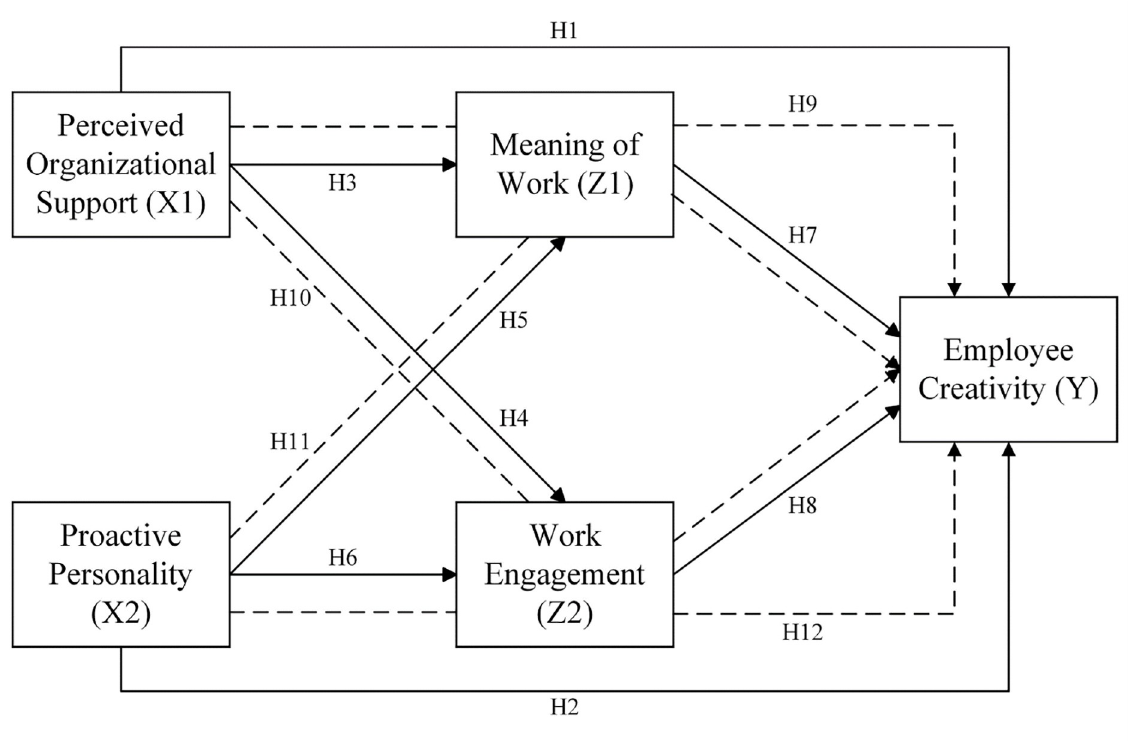
Fig 1. Conceptual